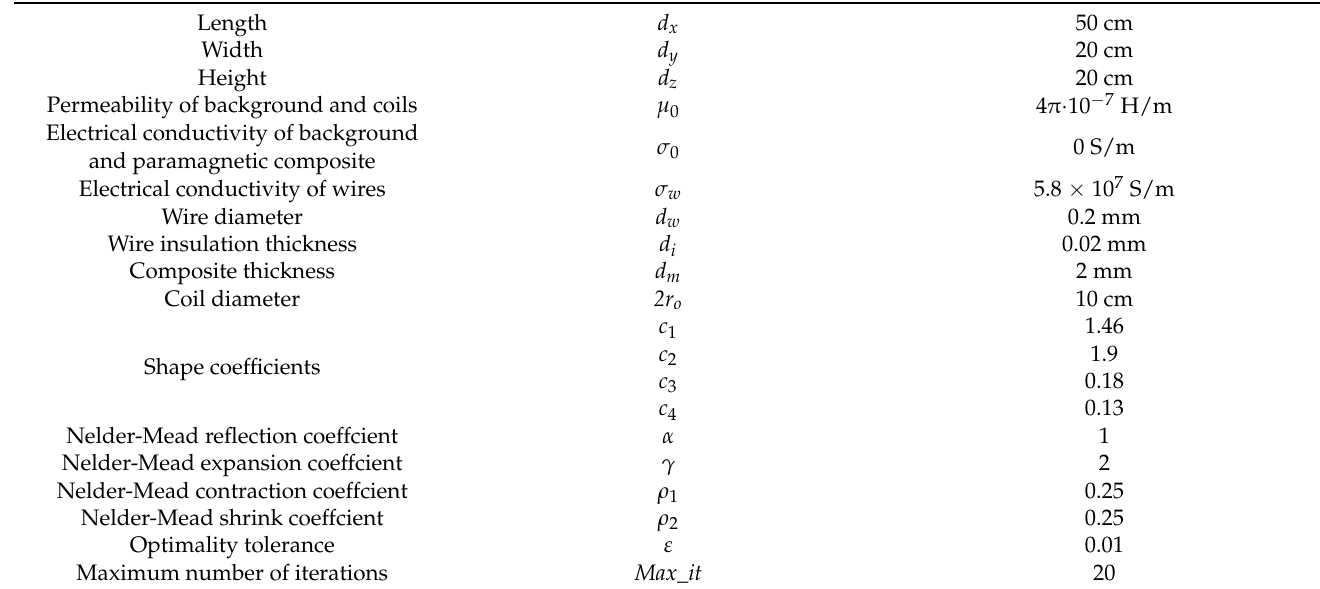
Table 1. Parameters used during